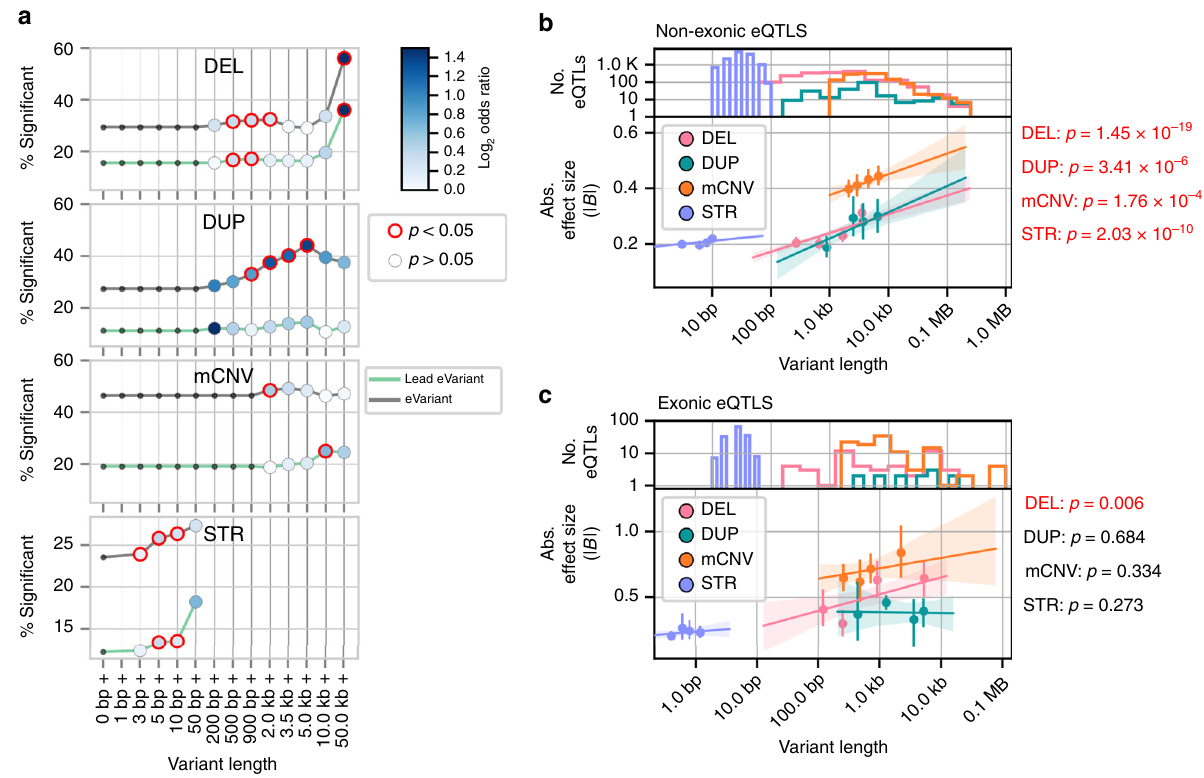
Fig. 2 Variant length in fl uences the likelihood and effect size of eQTLs. a Percentage of variants with length greater than the thresholds on the x axis that were eVariants (grey lines) or lead eVariants (green lines). Points are colored according to the enrichment (log 2 odds ratio) of variants above each threshold among eVariants or lead eVariants relative to variants smaller than the threshold; points circled in red were signi fi cant (FET two-sided, p < 0.05). A complete list of p values and odds ratios is provided in Supplementary Fig. 4. ( b , c ) Association of variant length with eQTL effect size for ( b ) non-exonic eQTLs or ( c ) exonic eQTLs mapped to biallelic deletions ( n = 1,769 non-exonic, n = 48 exonic), duplications ( n = 235 non-exonic, n = 13 exonic), multi- allelic CNVs ( n = 1,278 non-exonic, n = 111 exonic) and STRs ( n = 13,085 non-exonic, n = 148 exonic). Number of eQTLs for each variant class at de fi ned length is shown in top panels. Points in bottom panels represent the centers of bins with equal numbers of observations and error bars indicate 95% con fi dence intervals around the mean (1000 bootstraps). Lines represent linear regressions, with 95% con fi dence intervals shaded, as calculated on unbinned data. p values at the right of each plot indicate the signi fi cance of the association between length and absolute effect size (linear regression, t-test) in a model that includes non-mode allele frequency and distance to TSS as covariates. p values presented are not adjusted for multiple